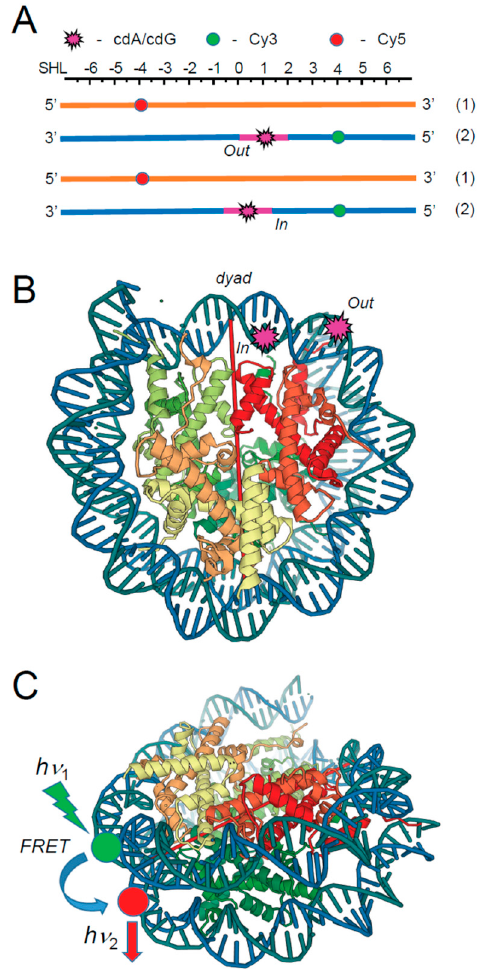
Figure 6. ( A ) Schematic illustrations of the placements of the DNA lesions and the Cy3 donor and Cy5 acceptor molecules at the “ Out ” and “ In ” rotational settings in the 147-mer 601 DNA duplexes used in the Förster Resonance Energy Transfer (FRET) experiments. ( B ) The crystal structure of the 601 nucleosome core particles (PDB 3LZ0) [67]. The dyad axis is indicated by the red line. ( C ) Positions of the Cy3 donor and Cy5 acceptor molecules in the nucleosome FRET experiments. The lesions were positioned at the 66th or 70th nucleotide (nt) counted from the 5 ′ -end of the 147-mer, corresponding to the Out or In rotational settings. The internal Cy3 and Cy5 labels were positioned at nucleotides 43 and 39 counted from the dyad axis in opposite strands. Reproduced from reference [66].